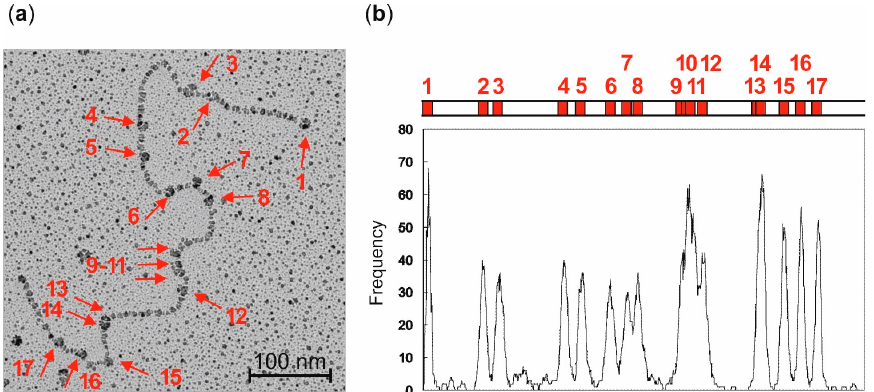
Figure 4. Electron microscopic localization of streptavidin-biotin complexes on labeled LpUC19 plasmid DNA. ( a ) Electron microscopic picture of one LpUC19 plasmid, which was biotinylated with M.HhaI and aziridine cofactor 5 and incubated with streptavidin. The streptavidin molecules